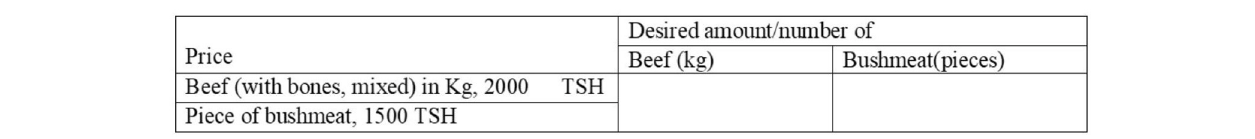
FIGURE 2 | Example of a choice card with the associated question—how many piles/Kgs/pieces/number of the two types of meat would you buy at the indicated